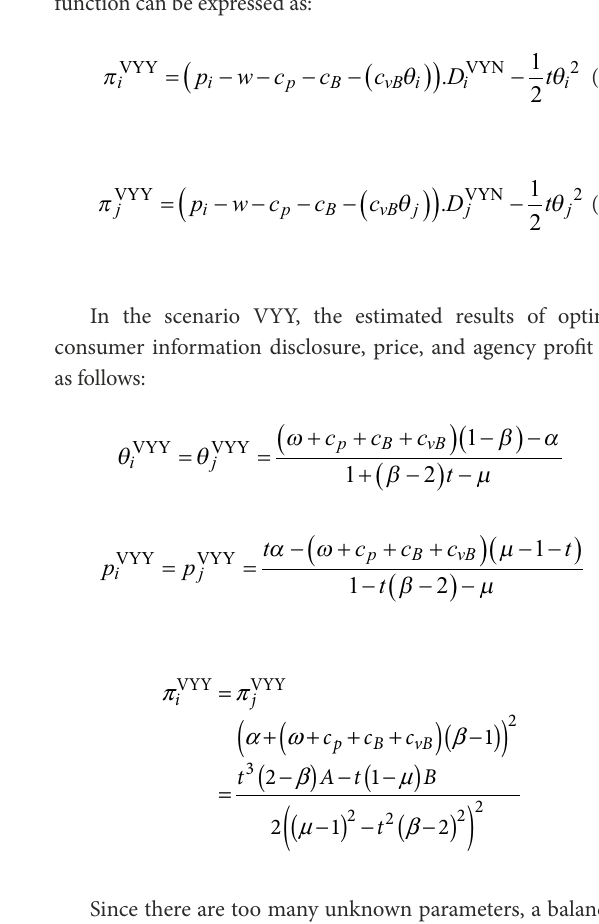
FIGURE 8 DYY-Agent i ( j